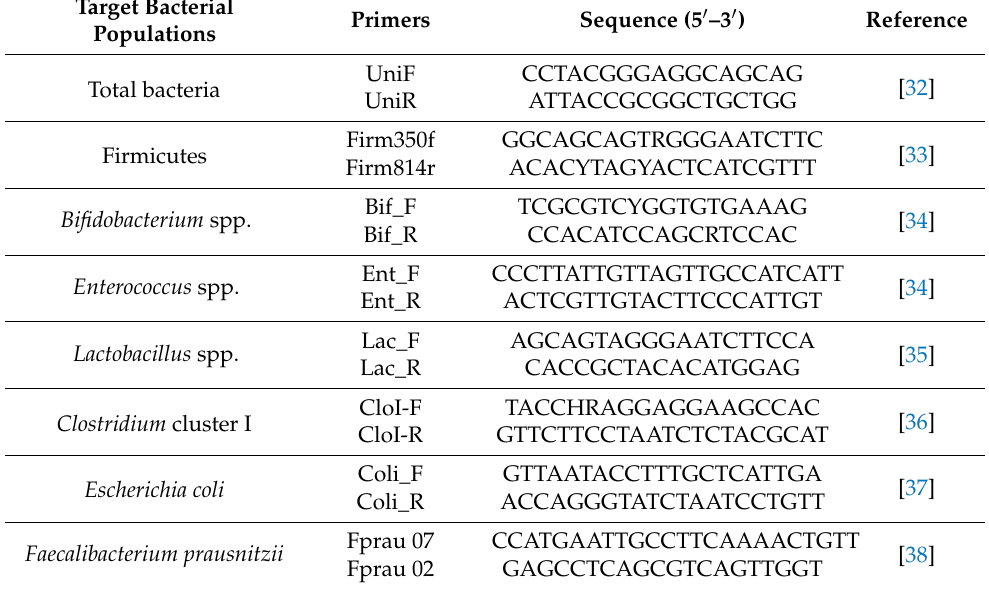
Table 2. Primers used for quantitative PCR